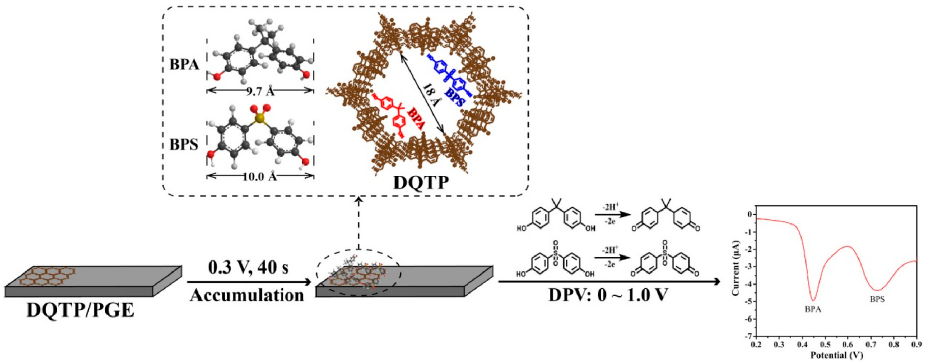
Figure 5. Schematic illustration of a DQTP-based electrochemical sensor for the simultaneous determination of BPA and BPS from Ref. [78]. Copyright 2022 Elsevier.